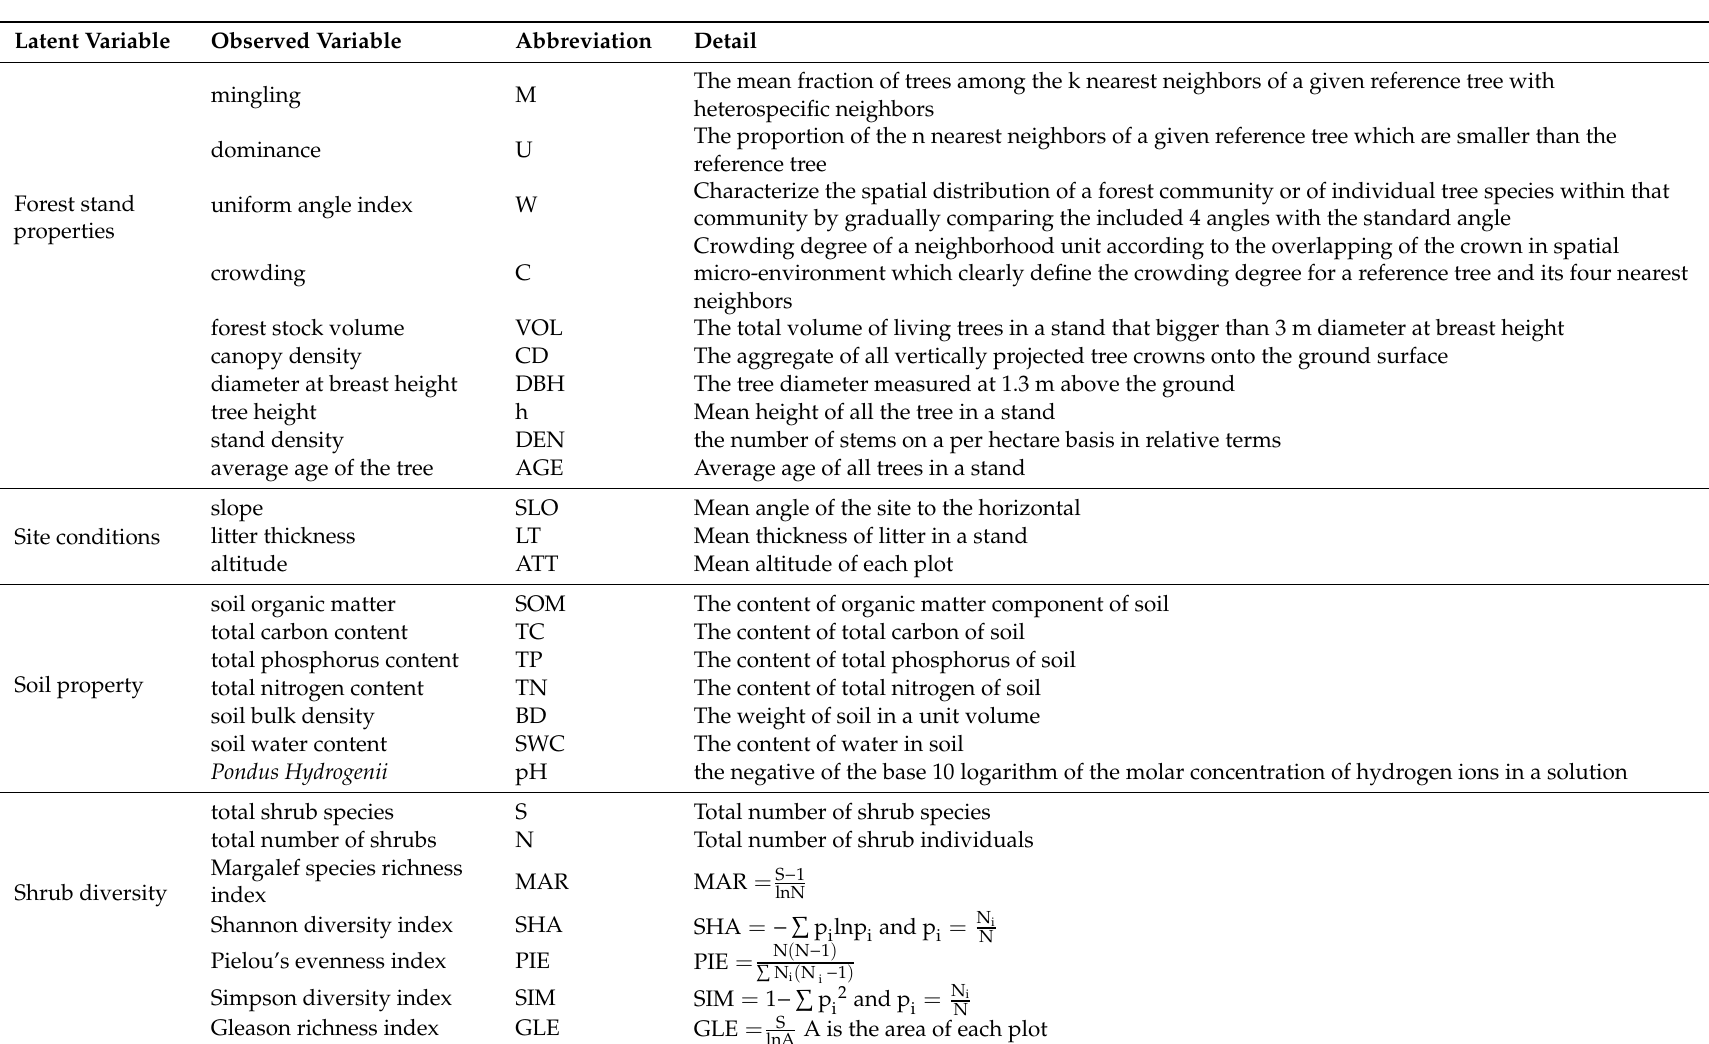
Table 1. Details of variables used in the